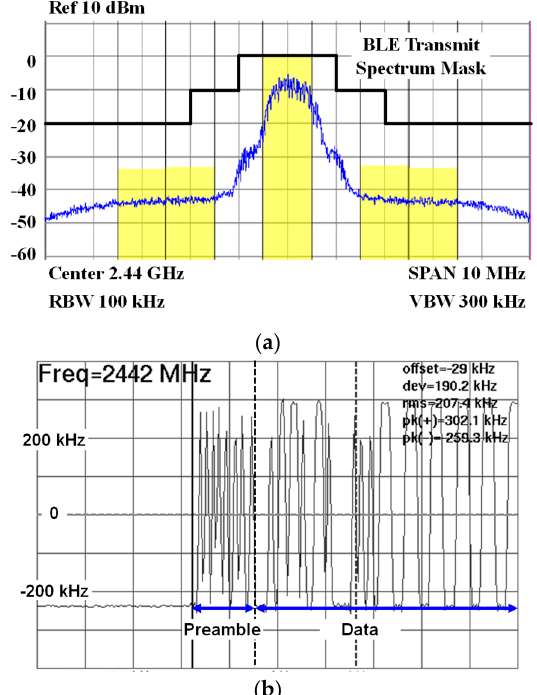
Figure 29. ( a ) Spurious emission mask of TX and ( b ) demodulated TX frequency for the BLE